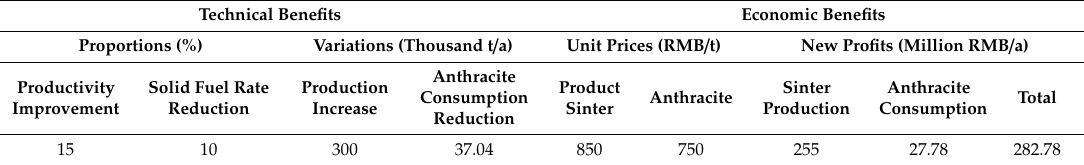
Table 8. Anticipated techno-economic benefits of pressurized densification sintering process.